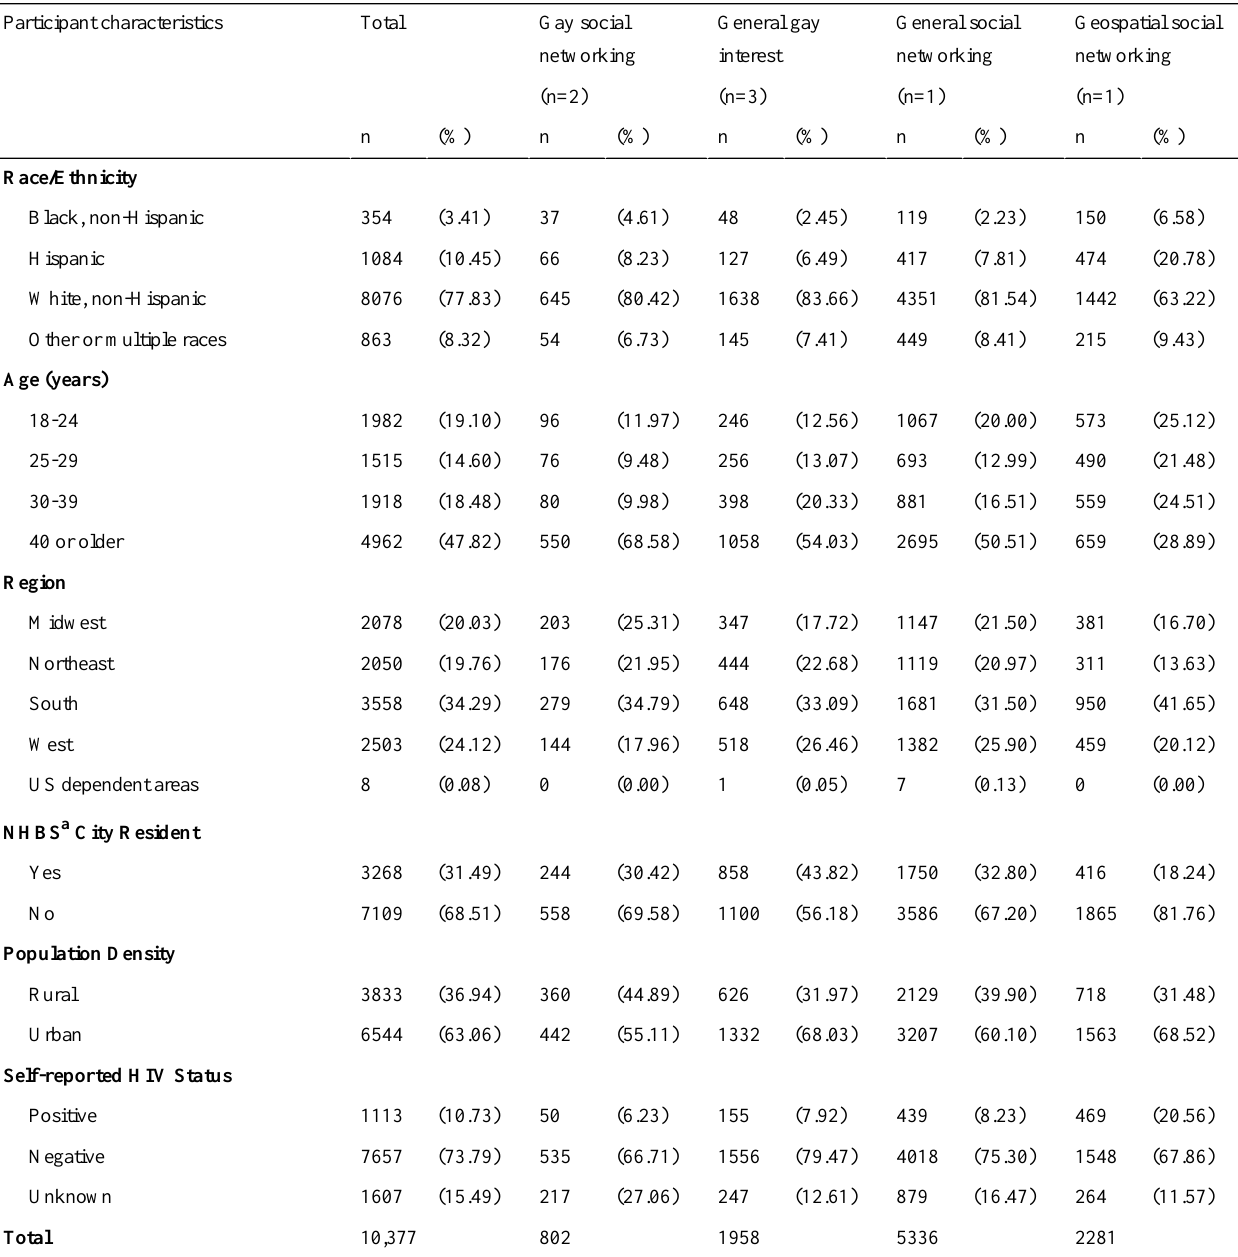
Table 2. Characteristics of MSM participants in the American Men's Internet Survey by recruitment website type, United States, 2013.